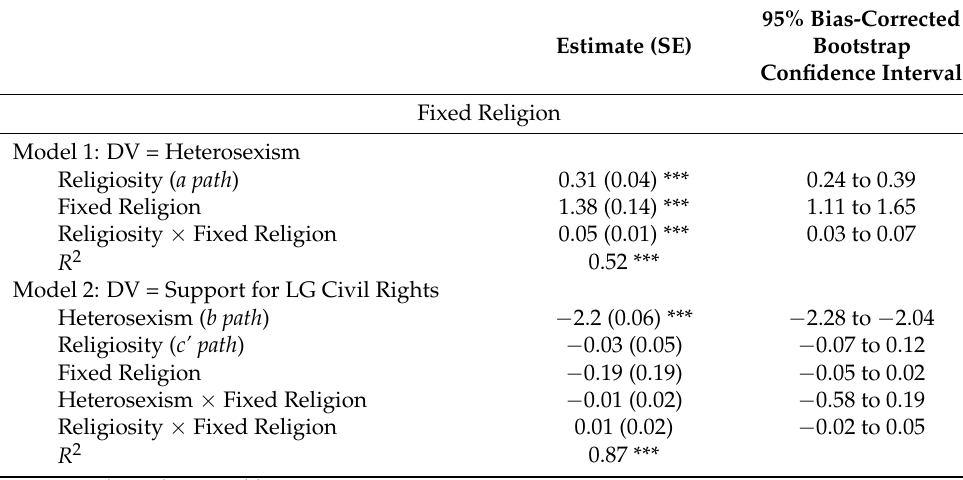
Table 4. Moderated Mediation Model Summary with Fixed